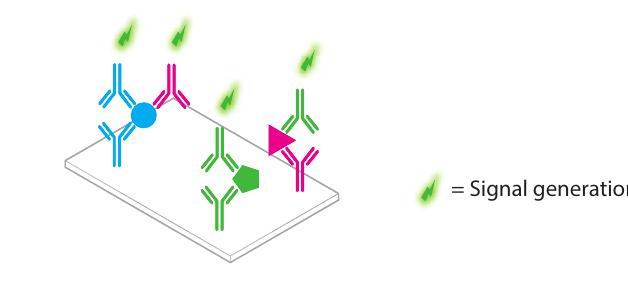
Figure 1. When trying to multiplex a typical ELISA, the risk of false positive detection due to immuno reagent cross-talk increases rapidly with increasing amounts of targeted analytes.